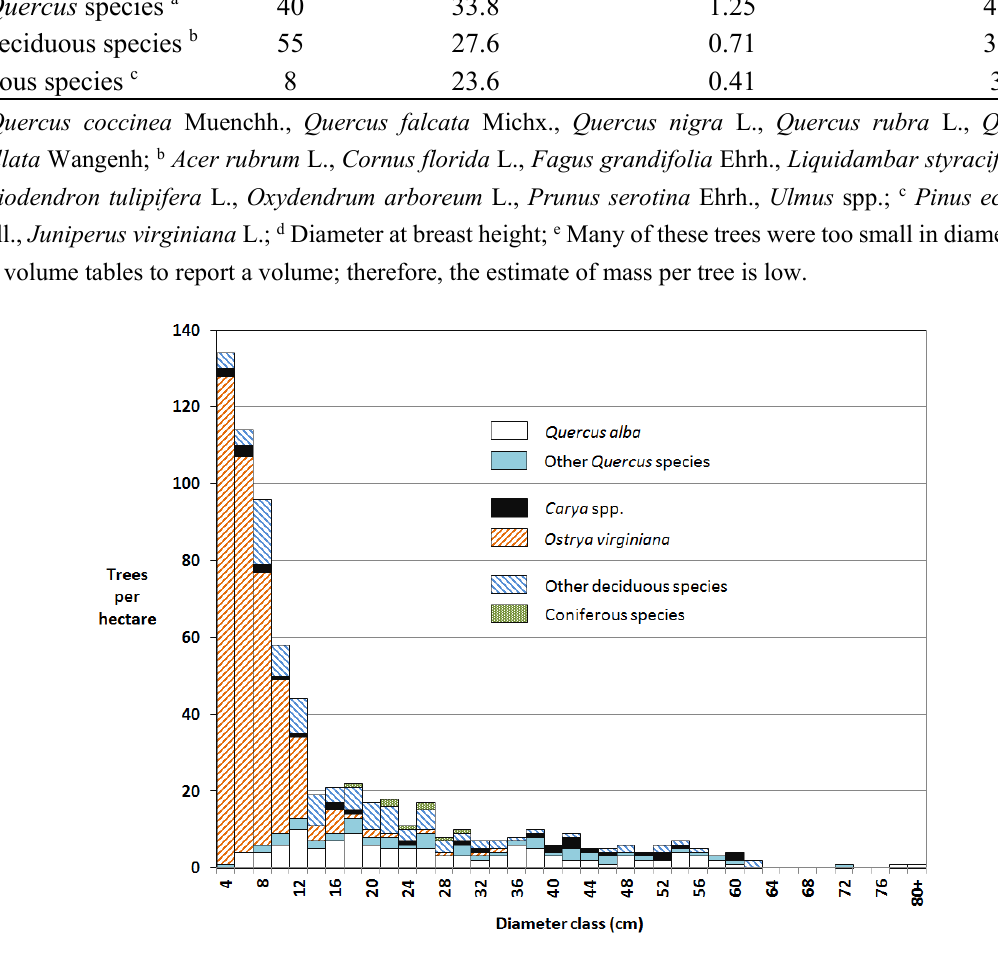
Mass per Hectare (Metric Tons)